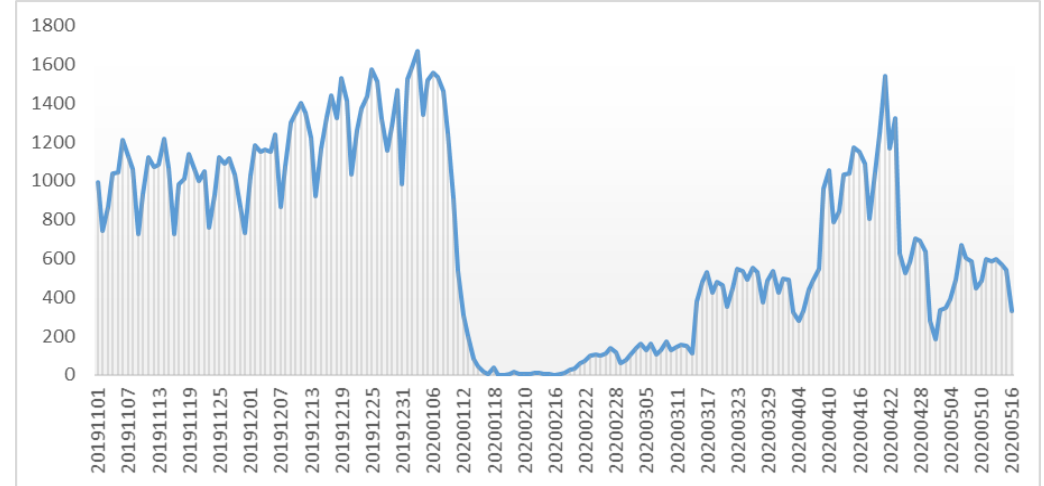
Figure 2. The truck flow of agriculture products during the COVID-19 pandemic (Unit: amount of truck).